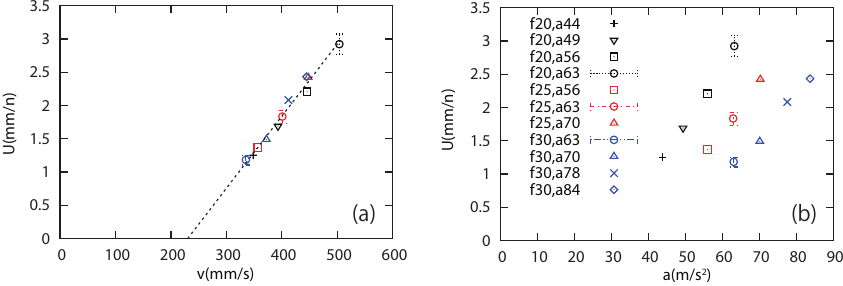
Figure 5. Rising "velocity," obtained as the slope of the z -vs-( n − n 0 ) curve, as a function of the vibration velocity v and the vibration acceleration a